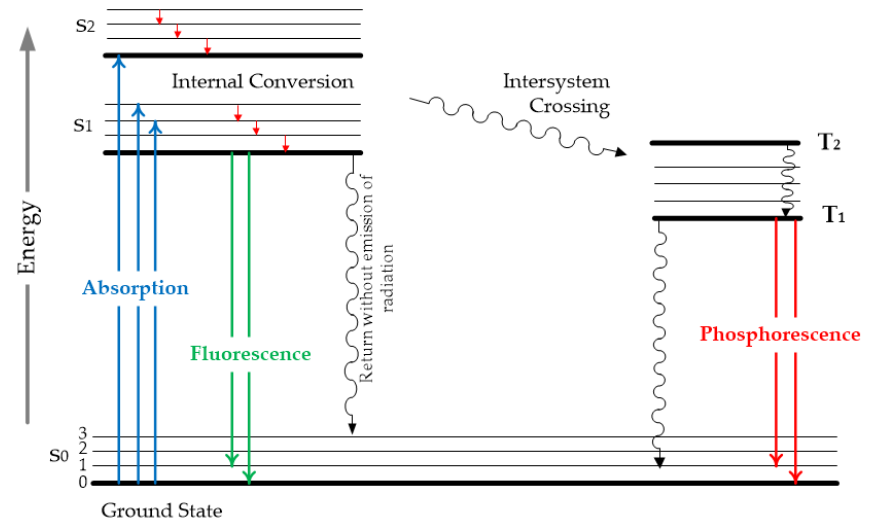
Figure 7. Jablonski diagram used to explain the luminescence processes. The phosphorescent phenomenon involves much longer durations than fluorescence, ranging between 1 μ s and 10 s. In addition, due to its low probability, the